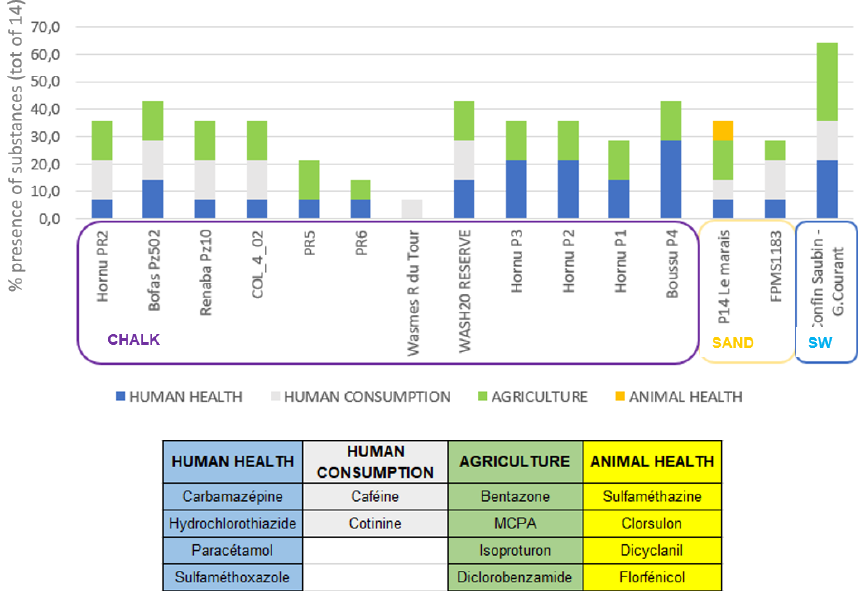
Figure 6. Occurrence of pharmaceutical substances in the sampling points of Boussu site (coupling the results from Autumn 2020 and Summer 2021): the table on the right summarizes the selection of substances for each category (maximum of 4), on the base of results on detected pharmaceuticals in the site and following the results of two other projects on that topic, IMHOTEP (Nott et al., 2018); BIODIEN (Frippiat et al.,